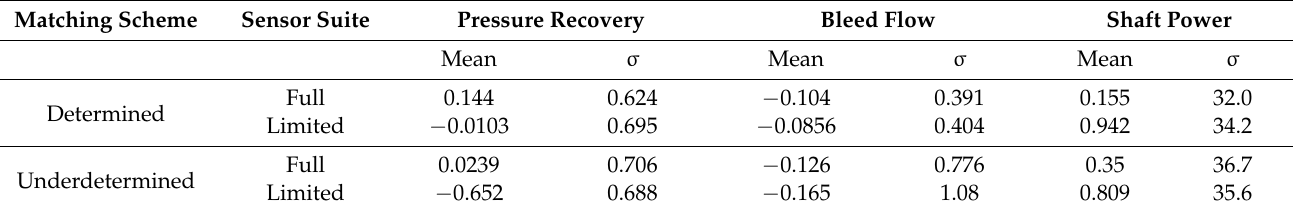
Table 8. Estimated installation effect deviation, with measurement